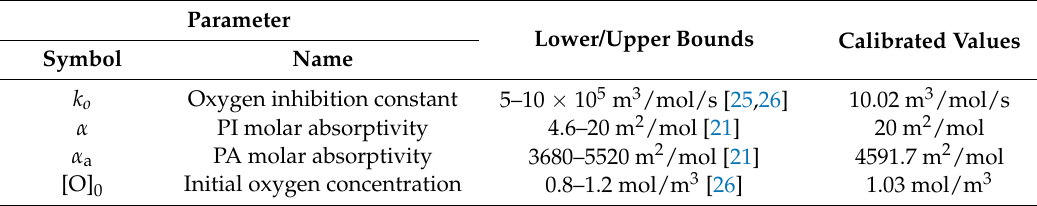
Table 3. List of calibrating